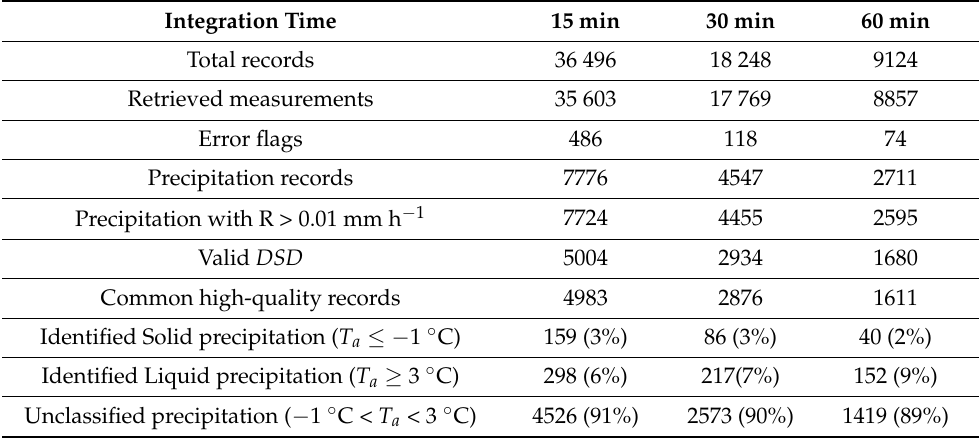
Table 4. Disdrometer data summary for the 15, 30, and 60 min time scales. Total number of records, errors, records with precipitation, and with precipitation rate >0.01 mm h − 1 are shown. The records with valid DSD and the common high-quality records containing (1) correct DSD , (2) correct bulk values, and (3) with precipitation > 0.01 mm h − 1 are also shown. Identified records as solid, liquid and unclassified precipitation are also included. The values in parentheses correspond to percentages of solid, liquid, and unclassified precipitation with regards to the number of records of the high- quality